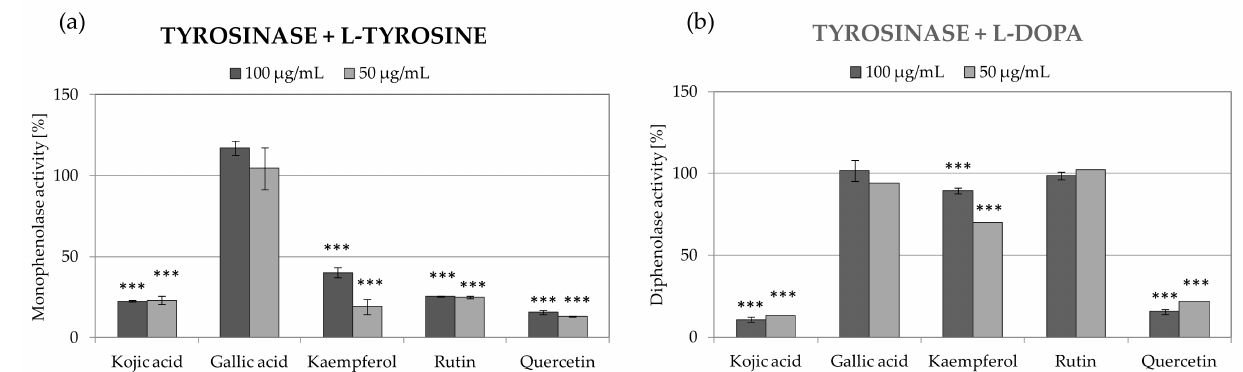
Figure 5. Inhibition of monophenolase ( a ) and diphenolase ( b ) activity of tyrosinase by main constituents identified in fraction E from extract R3, values on graphs represent mean ± SD ( n = 3), *** p <